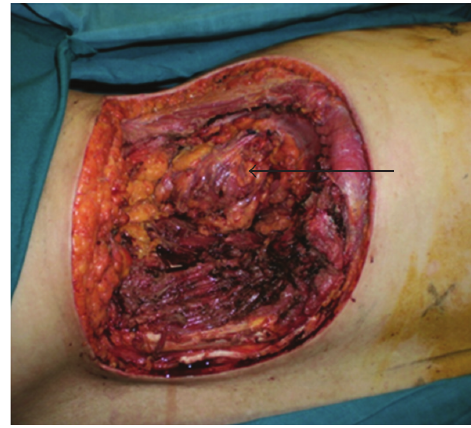
Figure 4: The defect showing the colonic flexure